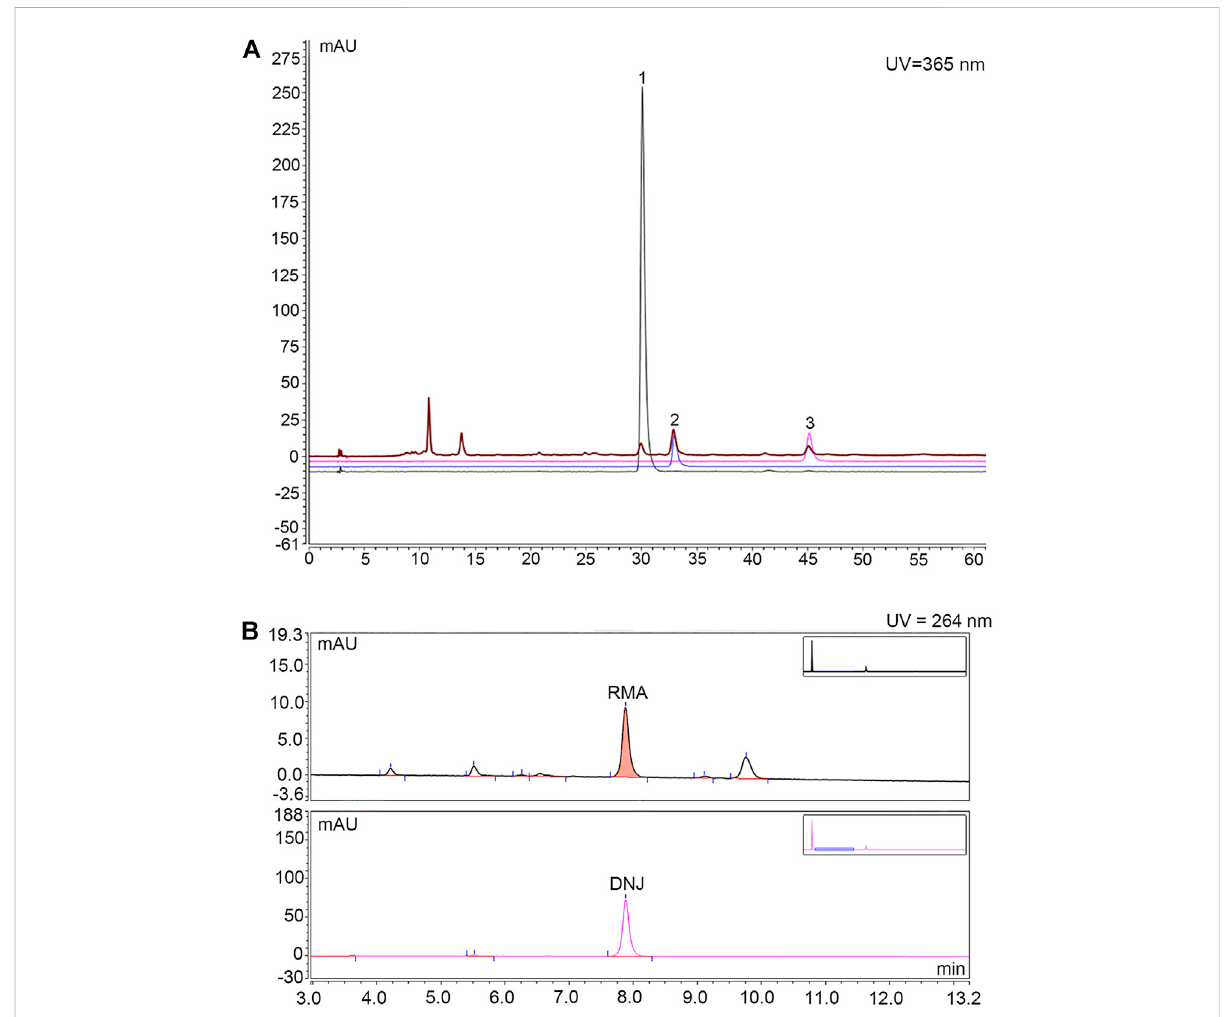
FIGURE 1 HPLCchromatogramfordeterminingthecontentofrutin,isoquercitrinandastragalininMLFandthecontentofDNJinRMA. (A) Determination of rutin, isoquercitrin and astragalin contents in MLFs by HPLC analysis. The black, blue and purple lines represent rutin, isoquercetin, and astragalin, respectively.ThebrownlinerepresentsMLF. (B) DeterminationofDNJcontentinRMAbyHPLCanalysis.TheupperhalfrepresentsRMA,whereasthe lower half represents DNJ.